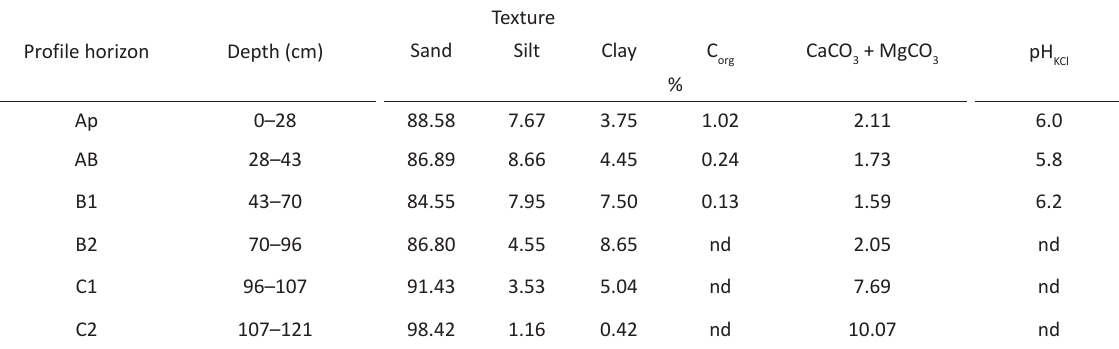
Table 1. Soil characteristics of experimental